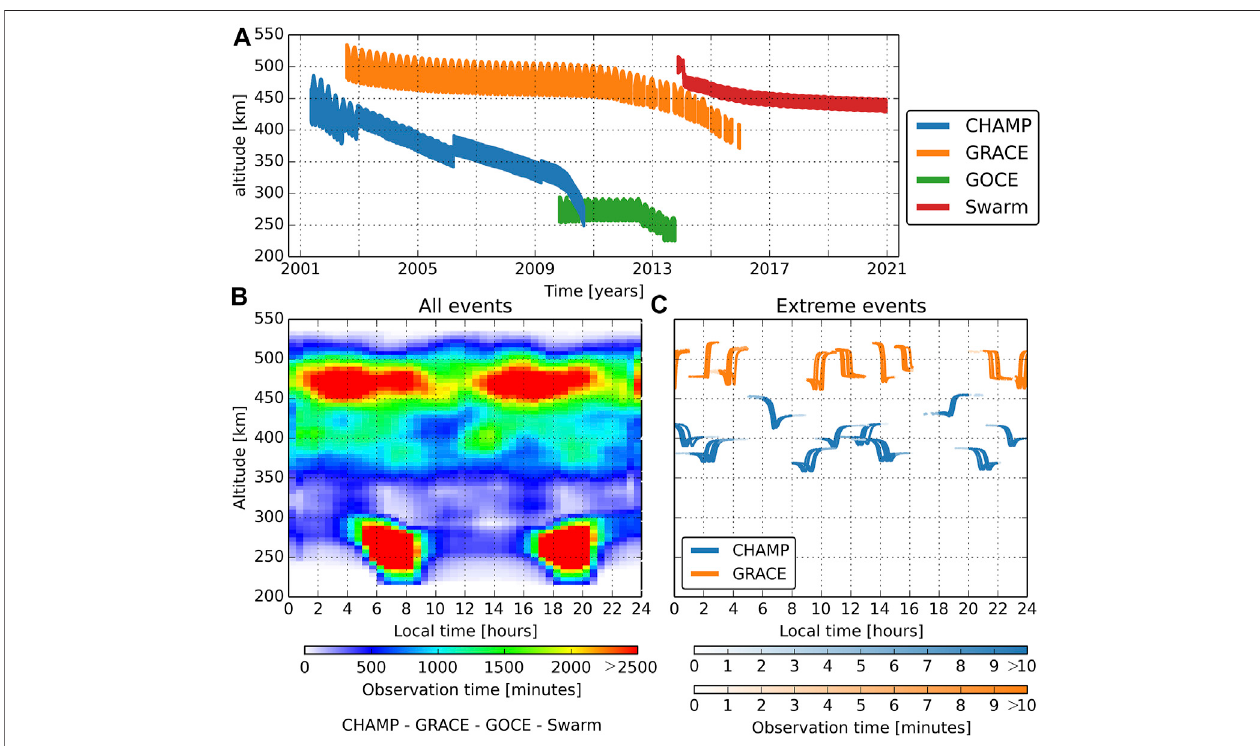
FIGURE1|(A) : CHAMP,GRACE,GOCE, and Swarm altitudes. Bottom row, (B) :superposed epoch analysisofsatellite observation times plotted asafunctionof localtimes andaltitudes. Thebinsizesare5 kmand 0.5 h. (C) :thesameasplottedintheleftpanel,butforthe7extreme magneticstorms (minimumSYM-H ≤ – 250 nT) observed by CHAMP and